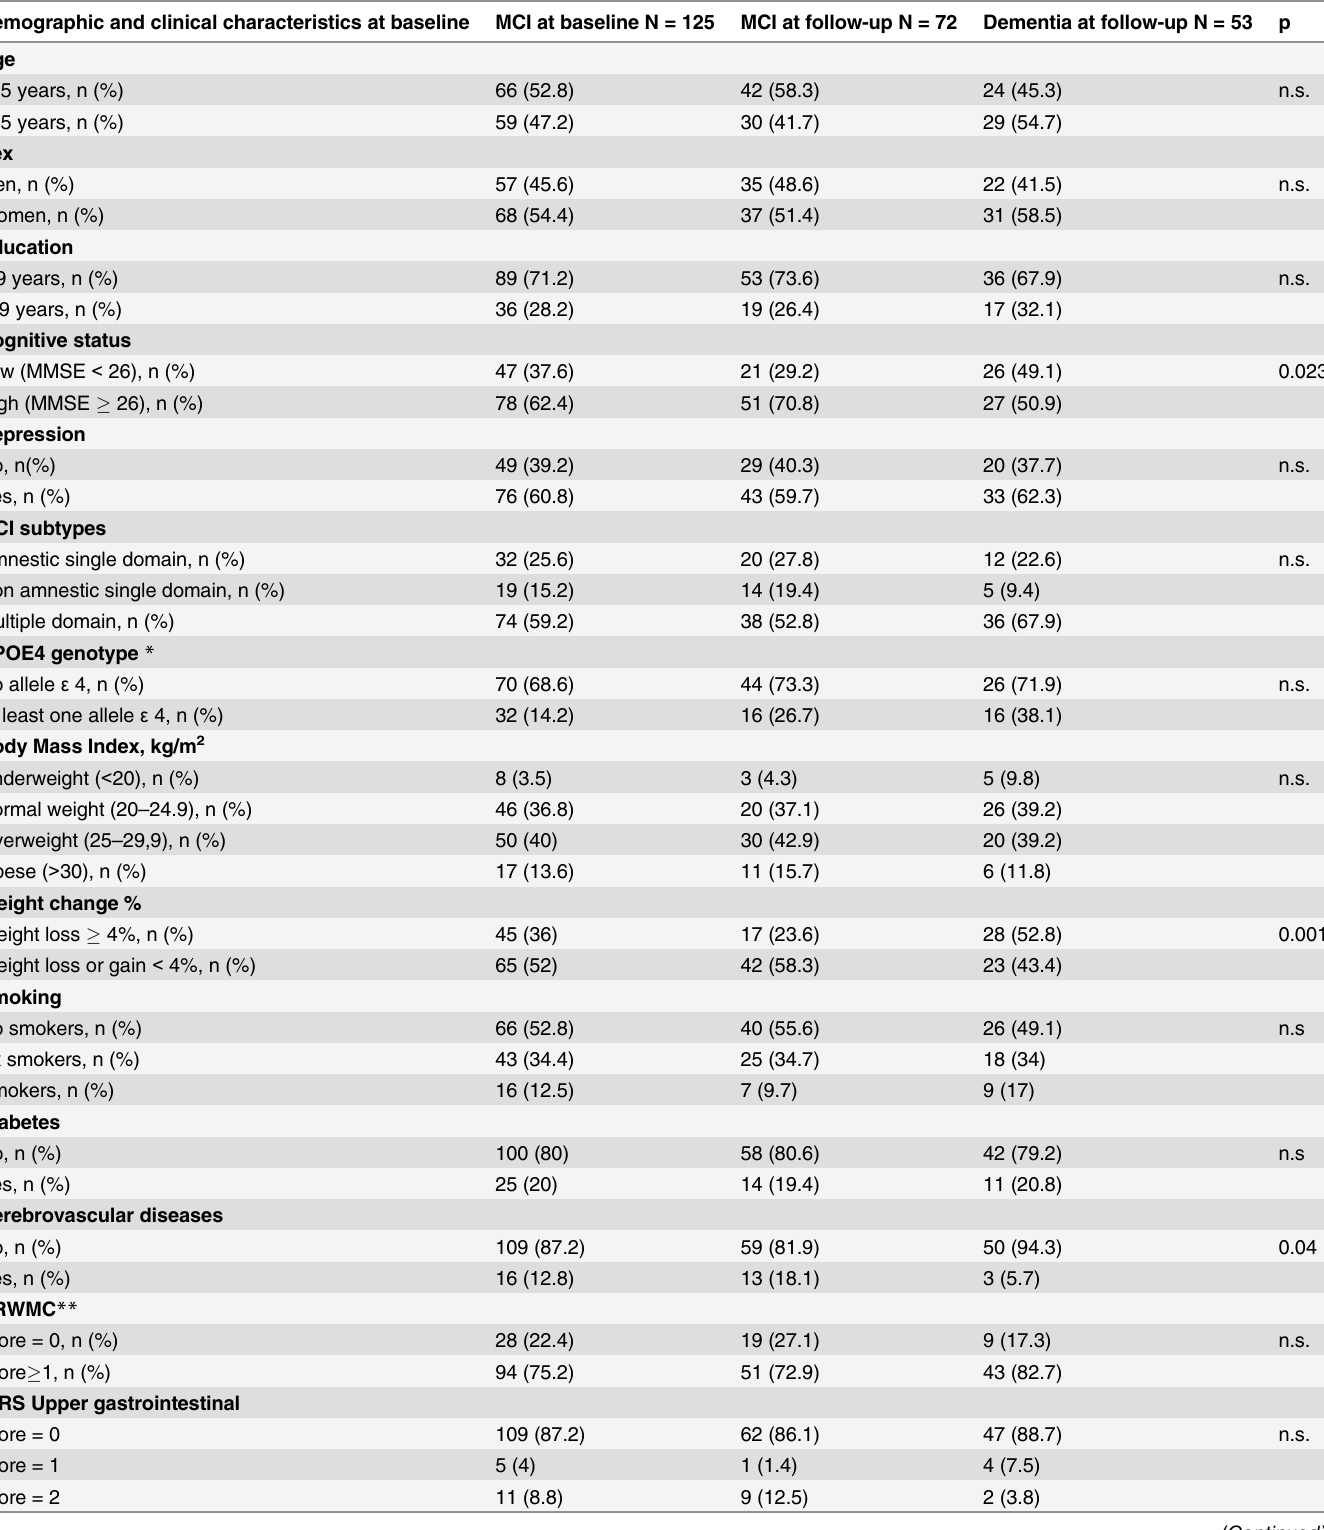
Table 1. Baseline characteristics and comorbidities in the whole sample, in stable MCI at follow up and in MCI progressed to dementia. Demographic and clinical characteristics at